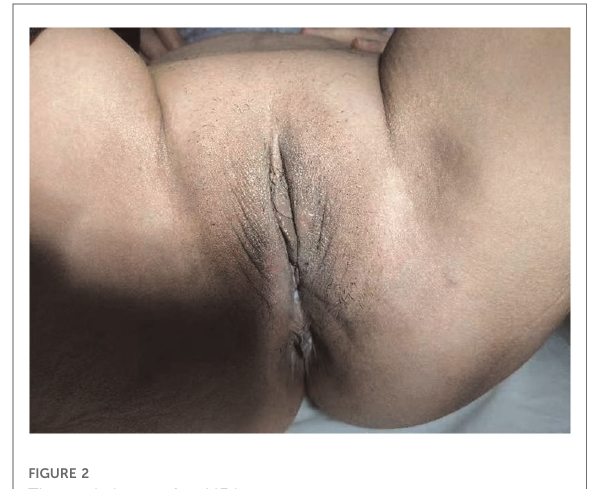
FIGURE 2 The genital area after MF laser treatment.